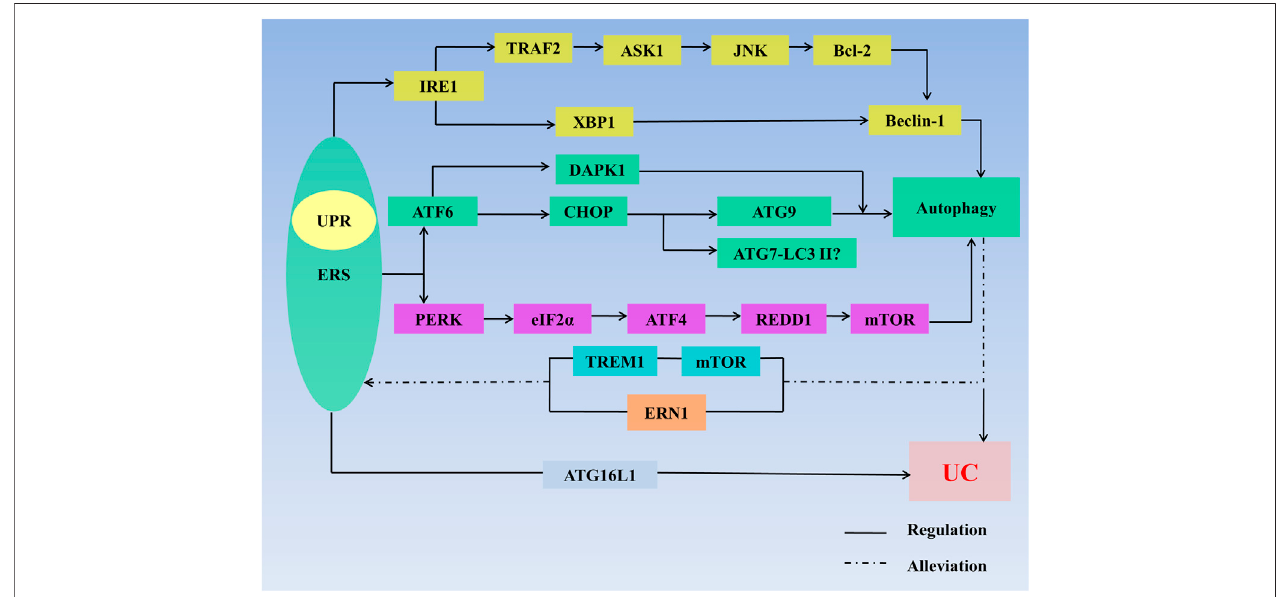
FIGURE 3 | ERS, autophagy, and UC. ERS regulates autophagy through multiple pathways: 1) IRE1/TRAF2/ASK1/JNK/Bcl-2/Beclin-1 signaling axis; 2) lIRE1/ XBP1/Beclin-1 signaling axis; 3) ATF6/CHOP/ATG9 signaling axis; 4) ATF6/DAPK1 signaling axis; 5) ATF6/DAPK1 signaling axis; 6)ATF6/CHOP/ATG7-LC3II signaling axis; 7) ATF6/CHOP/ATG9 signaling axis; and 8) PERK/elf2 α /ATF4/REDD1/mTOR signaling axis. ERS regulates UC through defects in the ATG16L1 gene. Autophagy stimulatesmTORreceptorsinIECstoinhibitTREM1andthroughregulatingERN1toalleviateERS.AutophagyalsoregulatesUC.TheinteractionbetweenERSand autophagy synergistically affects the development of UC. Abbreviations: AMPK, 5 ′ -monophosphate-activated protein kinase; ASK 1, apoptosis signal regulating kinase-1; ATF, activating transcription factor; ATG, autophagy associated gene; Bcl-2, B-cell lymphoma-2; CHOP, C/EBP homologous protein; DAPK1, death-related proteinkinase1;eIF2 α ,eukaryotic initiationfactor2 α ;ER,endoplasmicreticulum;ERAD,endoplasmicreticulum-associateddegradation;ERN1,endoplasmicreticulum to nucleus signaling 1; ERS, endoplasmic reticulum stress; LC3 Ⅱ , microtubleassociated protein light chain 3II; mTOR, mammalian target of rapamycin; IRE1, inositol- requiring enzyme1; JNK, c-Jun N-terminal kinase; PERK, protein kinase R-like endoplasmic reticulum kinase; TRAF2, tumor necrosis factor receptor – associated factor 2; TREM1, triggering receptor expressed on myeloid cells 1; XBP1, X-Box-binding protein 1; UC, ulcerative colitis; UPR, unfolded protein